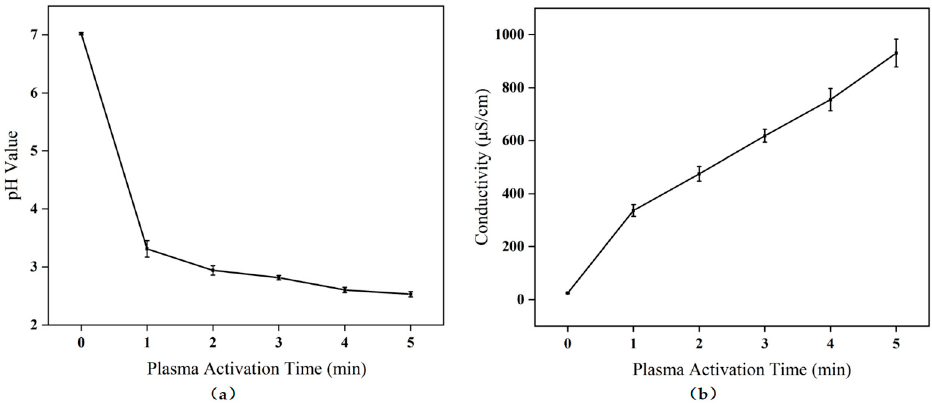
Figure 1. The values of ( a ) pH and ( b ) electrical conductivity with the plasma activation time in-